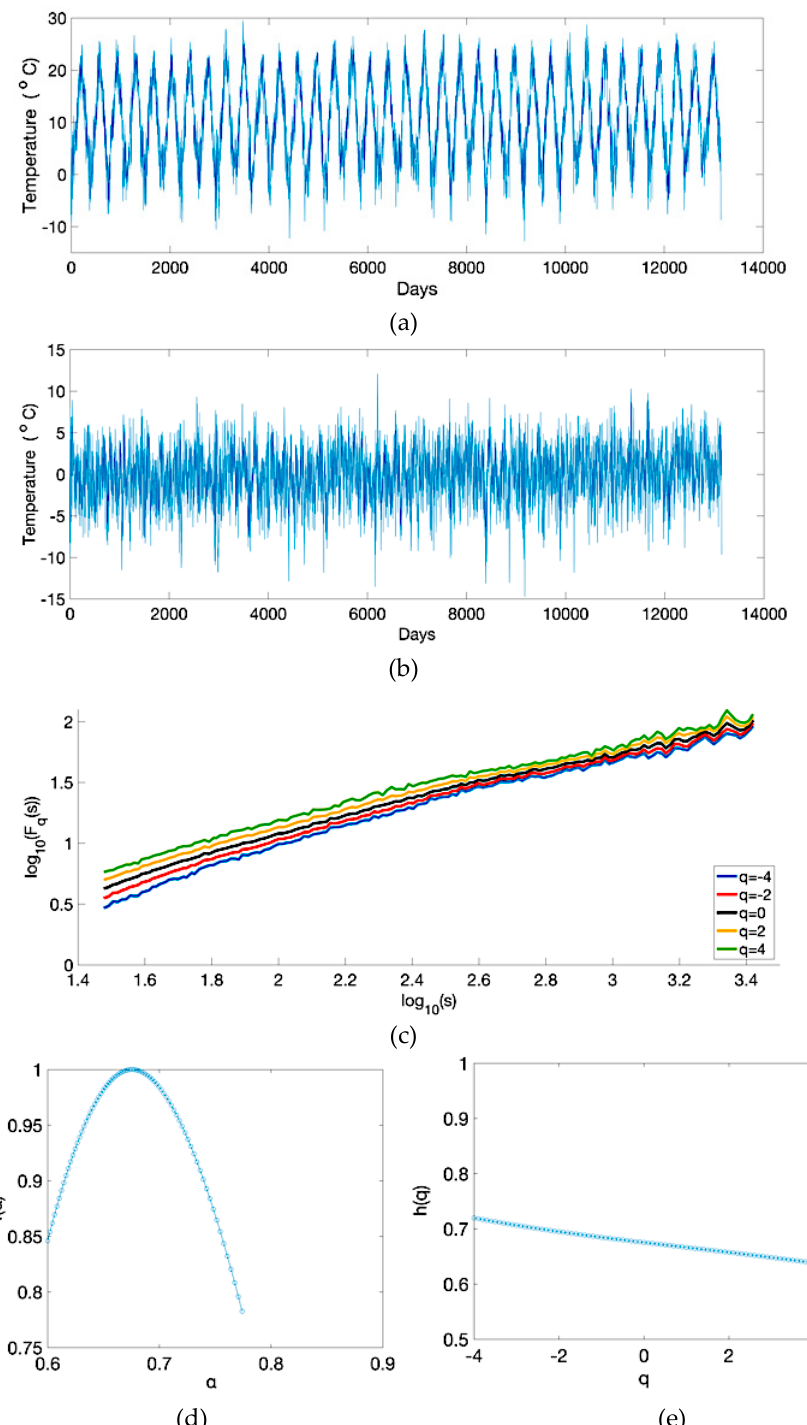
Figure 3. Original time series ( a ), deseasonalized time series ( b ), log-log plot of F q (s) versus s ( c ), multifractal spectrum f( α ) versus α for the nearest grid point to Kastoria (40.50° N, 21.00° E) ( d ) and generalized Hurst exponent h(q) versus q plot ( e ).